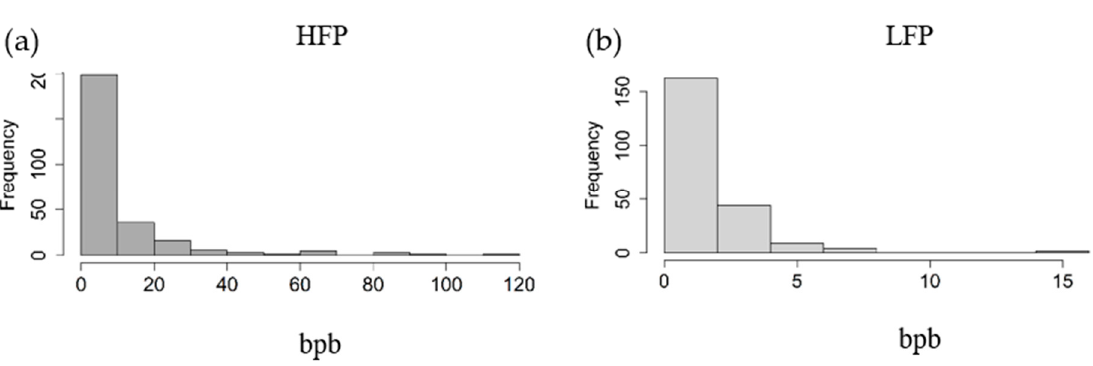
Figure 2. Histogram of feather pecks delivered in bouts per bird (bpb) for ( a ) the high (HFP, n = 270) and ( b ) low (LFP, n = 222) feather pecking lines. Note the different scales used for clarity.